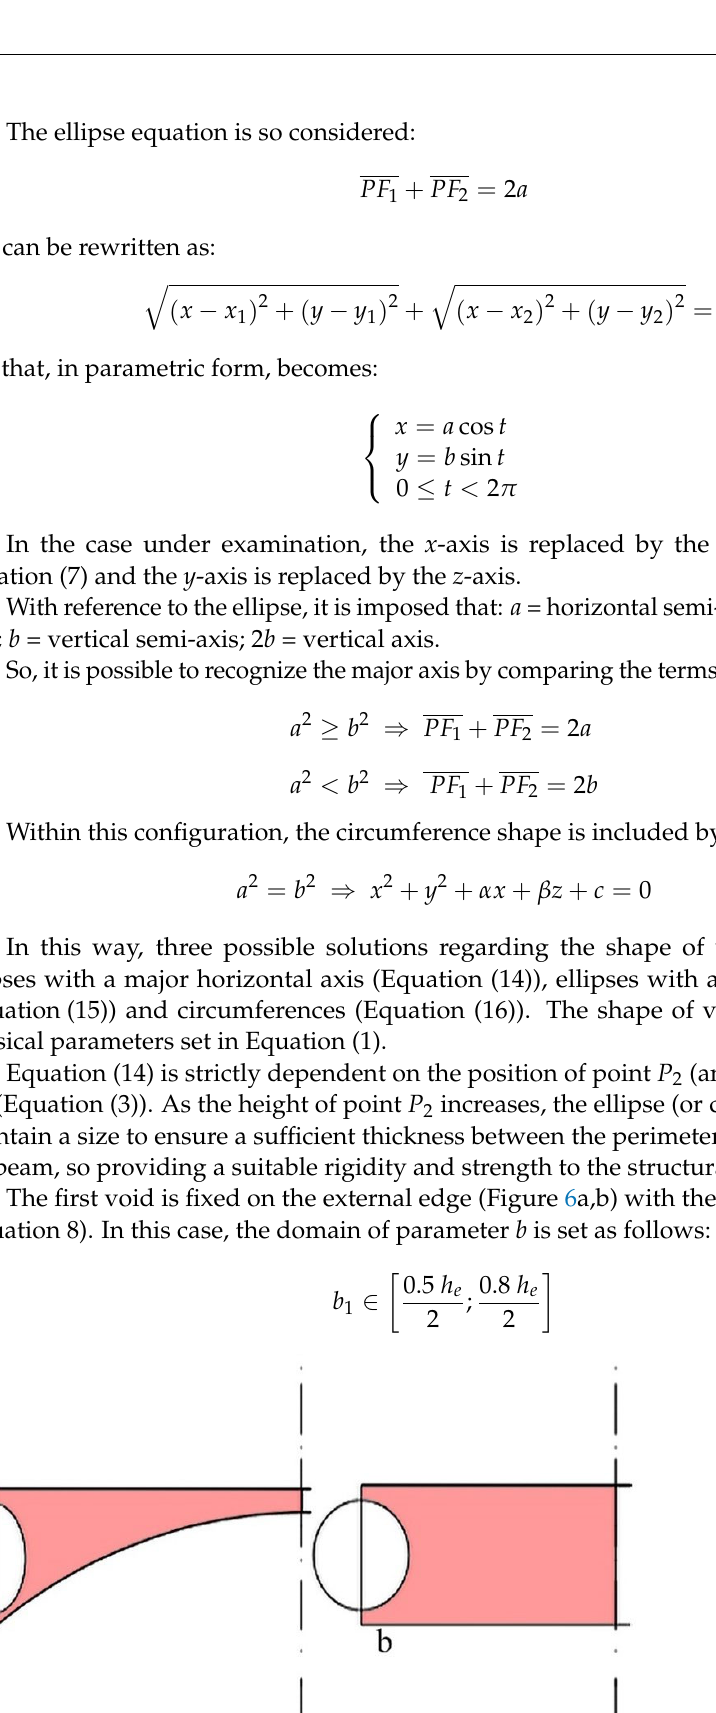
> 0; ( b ) edge void no.1 with ℎ 𝑚𝑚′